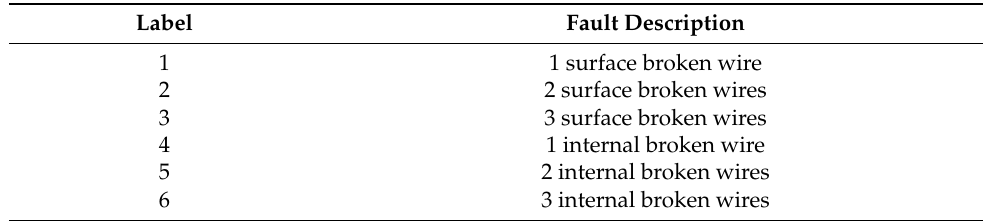
Figure 6. The wire rope with different defects. Table 1. Data description.